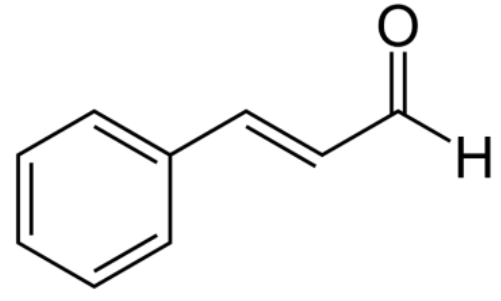
Figure 1. Chemical structure of cinnamaldehyde.